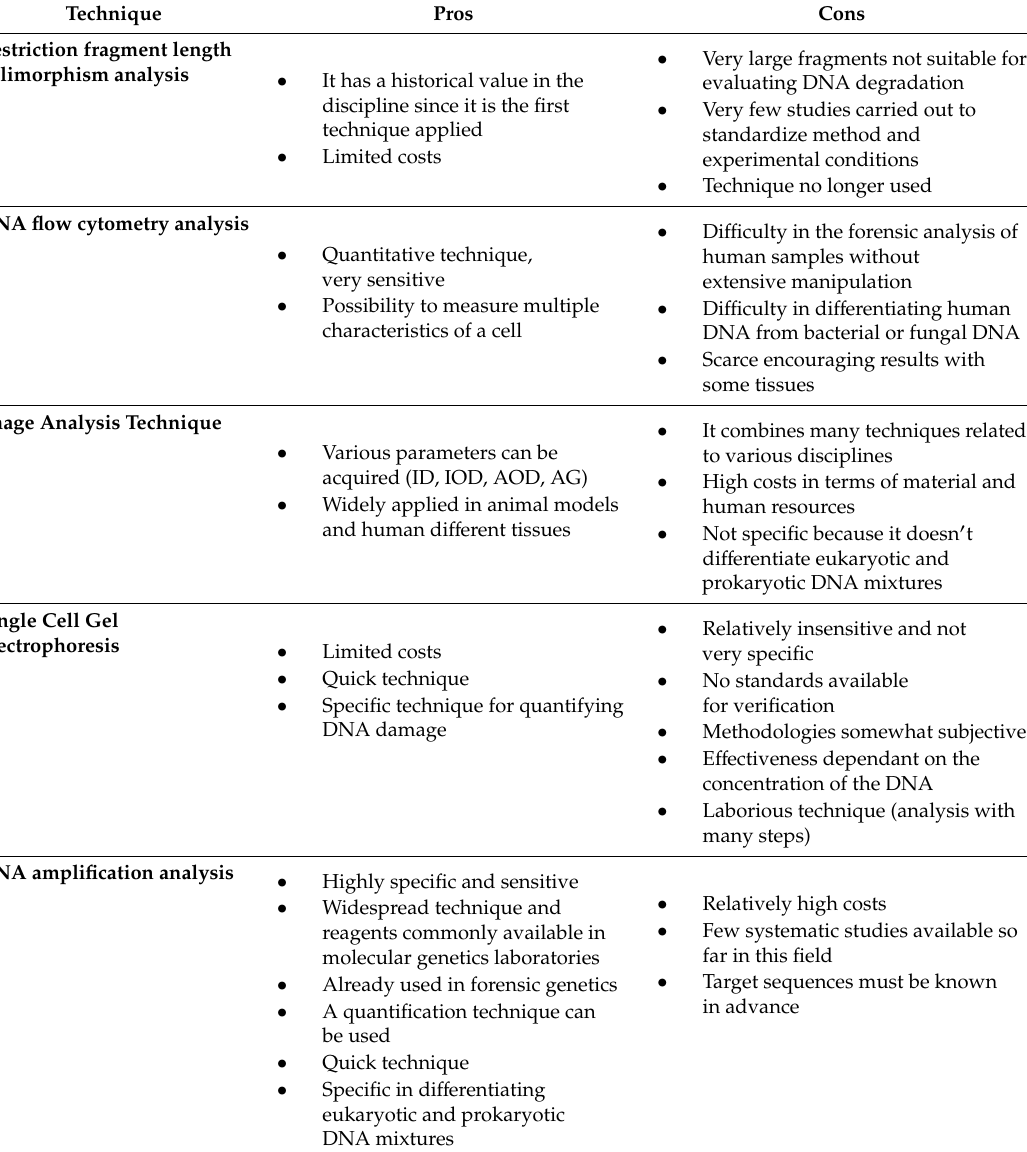
Table 2. Summary of the pros and cons of each of the techniques so far proposed in the literature for the estimation of PMI by DNA